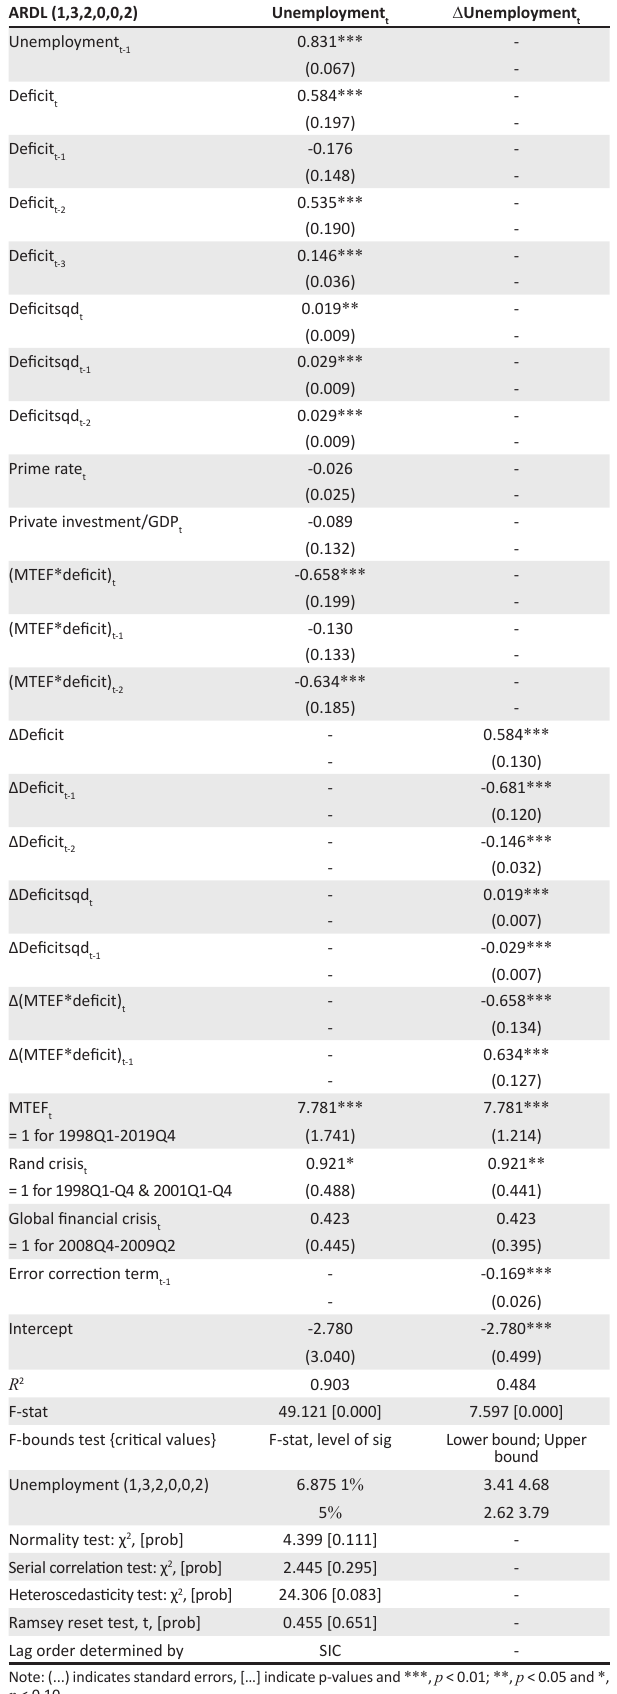
TABLE 4: Autoregressive distributed lag estimation